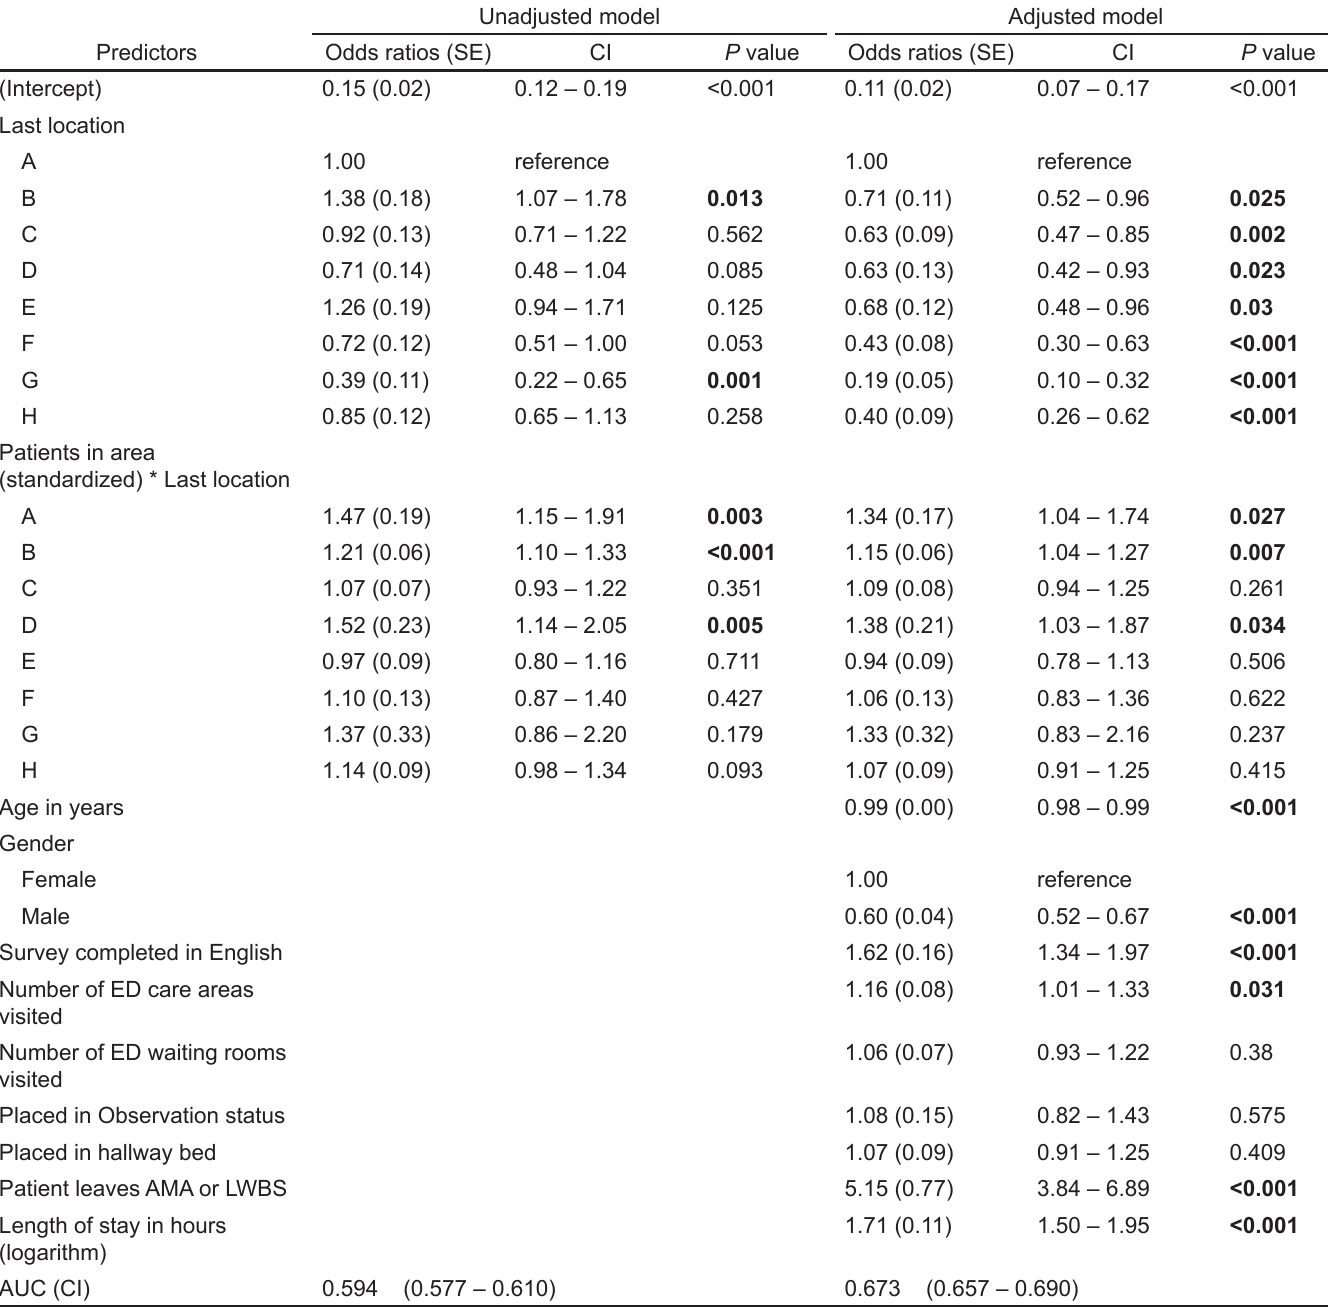
Table 3 . Logistic regression models for estimating a patient’s detractor